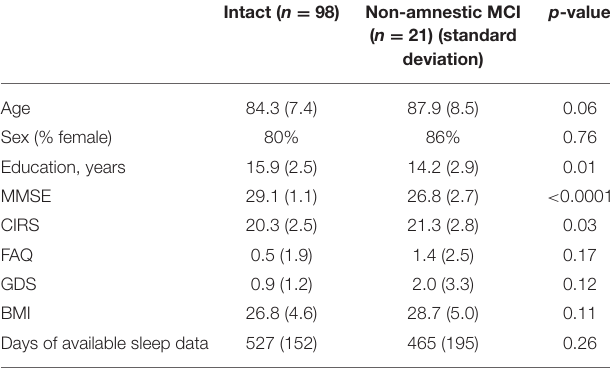
TABLE 1 | Demographic and clinical characteristics by cognitive group ( n =